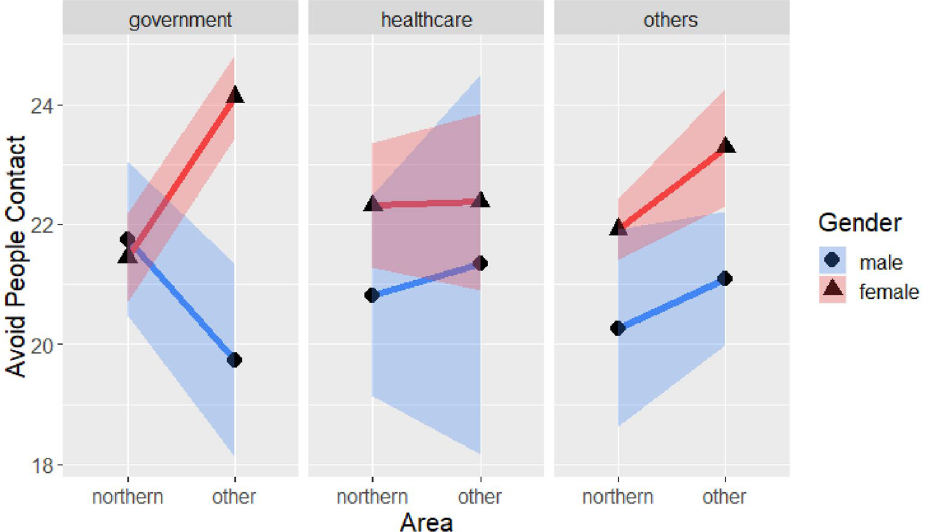
Figure 8. Three-way interaction of avoiding human contact with gender, region and